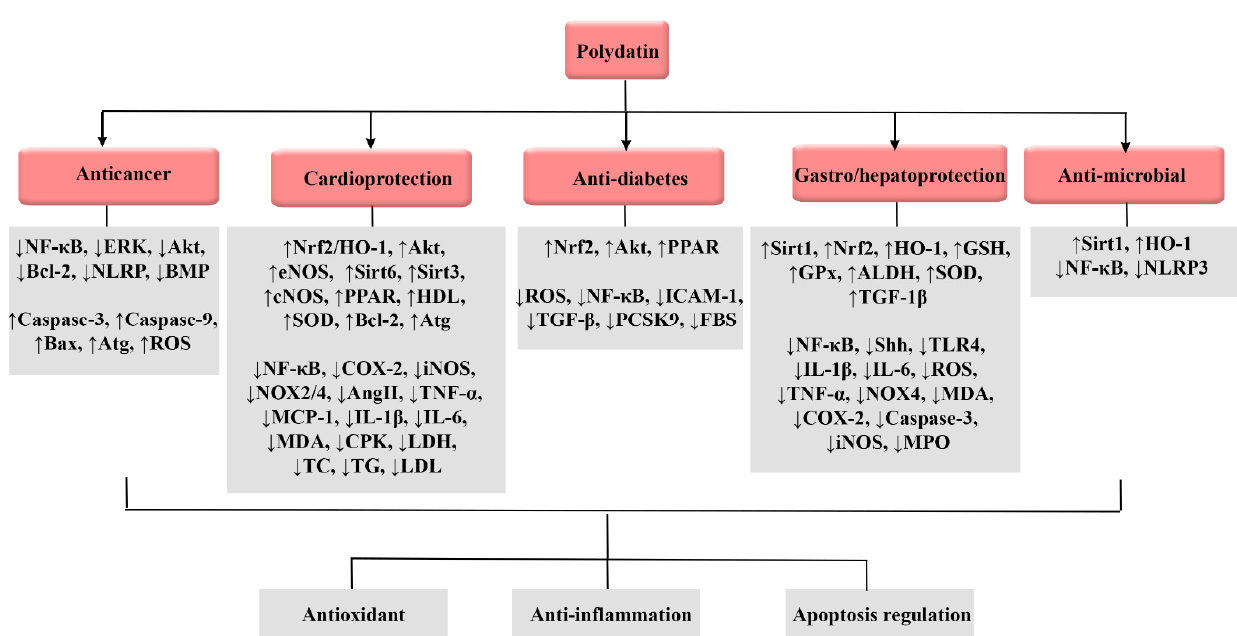
Figure 2. Therapeutic targets of polydatin against cancer, cardiovascular diseases, diabetes, gas- tric/hepatic failure, and infection. ADH: alcohol dehydrogenase, Akt: protein kinase B, ALDH: al- dehyde dehydrogenase, ALT: alanine transaminase, AST: aspartate transaminase, Atg: autophagy- related gene, Bax: Bcl-2-associated x, Bcl-2: B-cell lymphoma 2, BMP: bone morphogenetic protein,